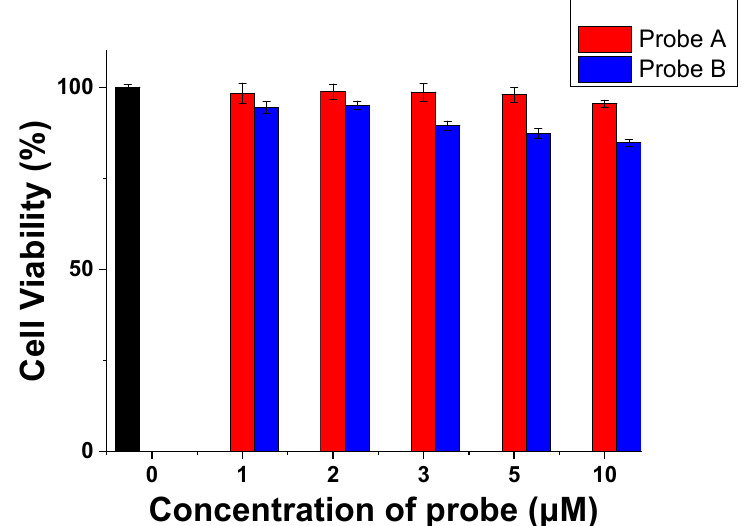
Figure 5. Cytotoxicity and cell proliferation of probes A and B conducted by MTS assay. HeLa cells were incubated with 1, 2, 3, 5, and 10 µ M of probes for 48 h, and cell viability was measured by adding MTS reagent and measuring at 490 nm at the average of three times. The black bar represents a blank control.